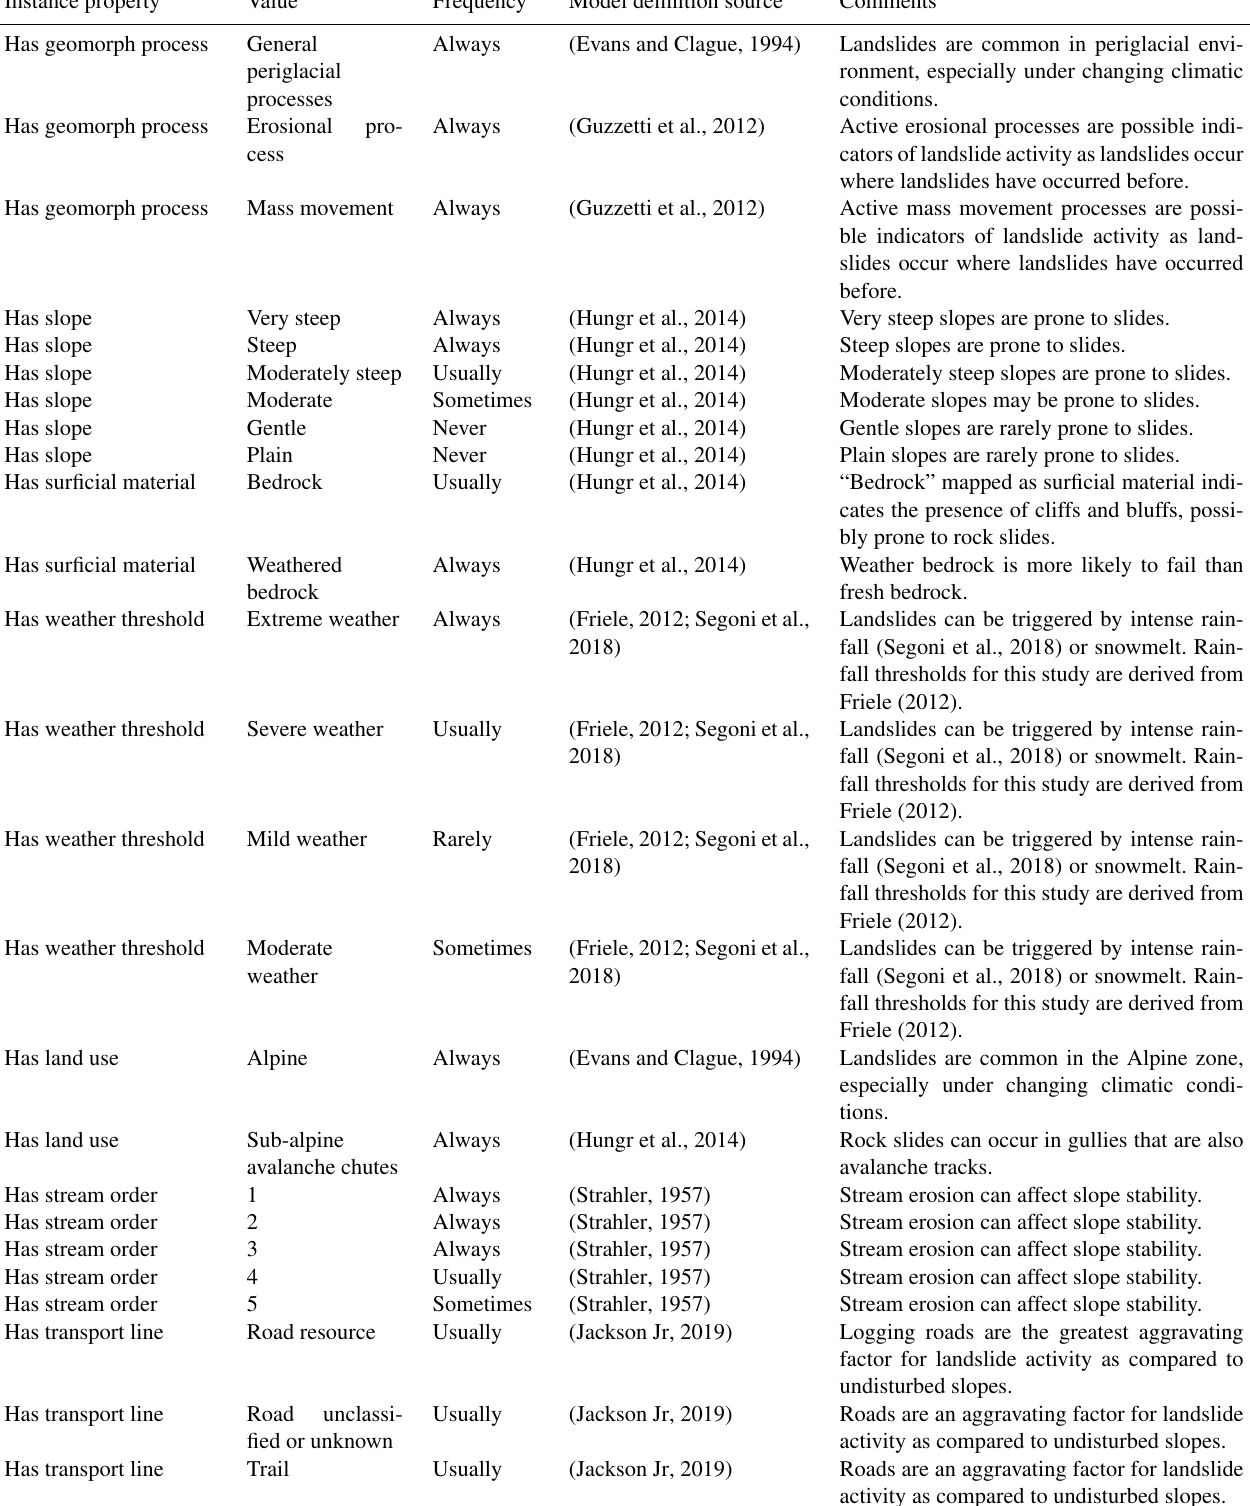
Table C2. Slides in rock model https://italy.minervageo.com/the-roberti-slides-in-rock-model/ (last access: 26 October